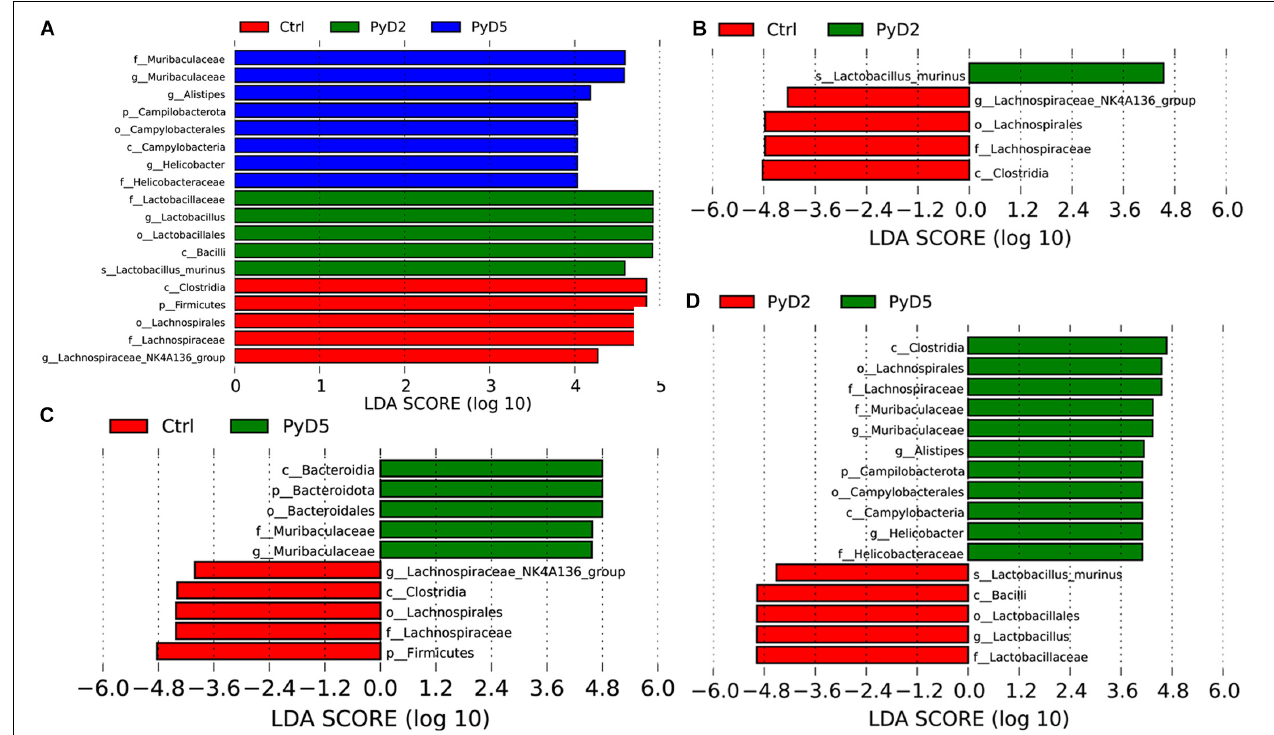
FIGURE 5 | LEfSe identified the bacterial taxa significantly differentiated among different groups. Only taxa with the statistical differences between groups were shown in the figure, which was determined by meeting an LDA significant threshold > 4. (A) Histogram of the linear discriminant analysis (LDA) scores distribution among three groups; (B) Histogram of LDA score distribution between the Ctrl and PyD2 groups. (C) Histogram of LDA score distribution between the Ctrl and PyD5 groups. (D) Histogram of LDA score distribution between the PyD2 and PyD5